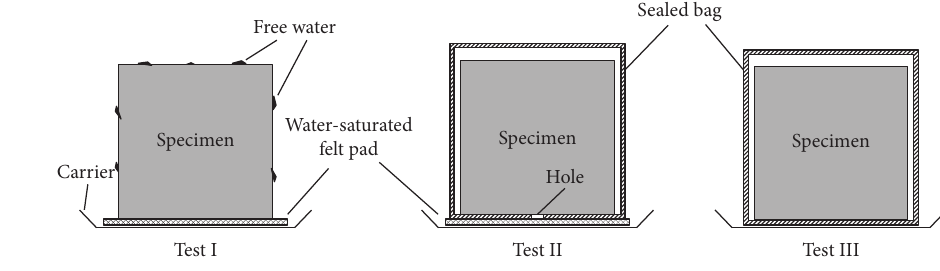
Figure 1: Sketch of the water supply conditions in the three tests. Table 4: Changes in UCS of stabilized soil after freeze-thaw cycles in three tests.